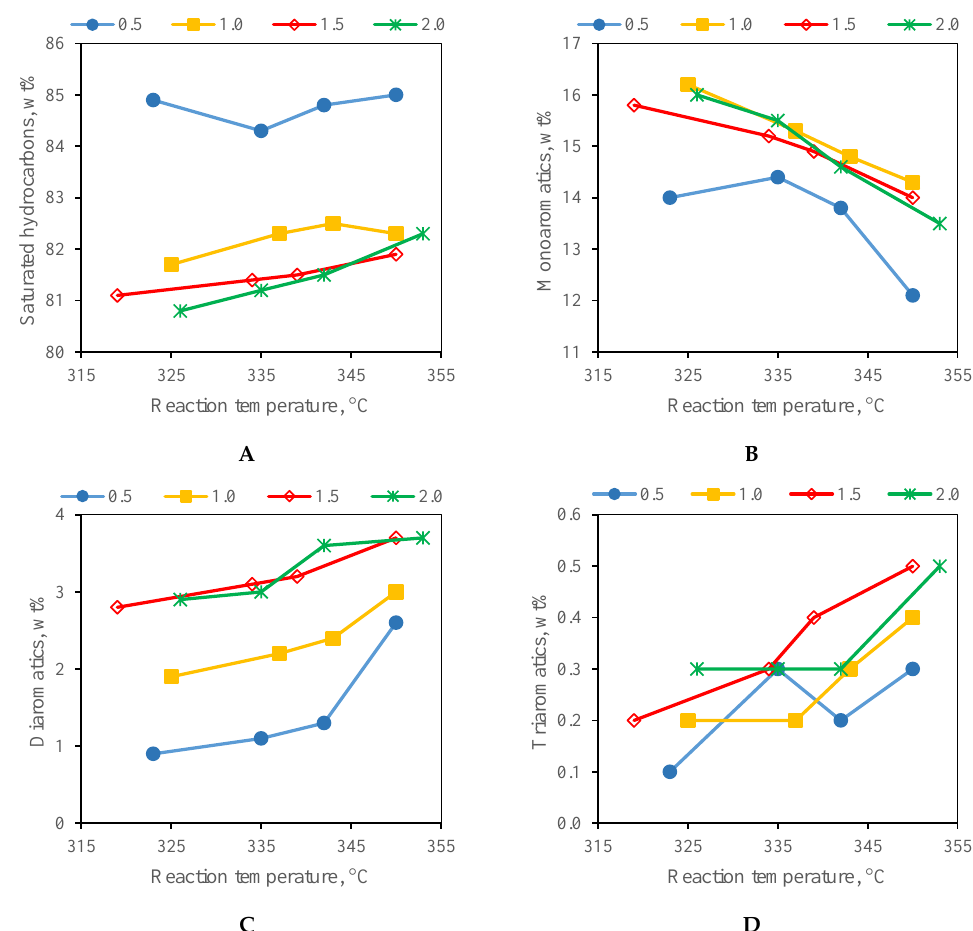
Figure 3. Group-type composition of all the liquid products obtained by the hydrotreating of F20 feedstock at the WHSV of 0.5–2.0 h −1 ( A ) saturated hydrocarbons; ( B ) monoaromatics; ( C ) diaromatics; ( D ) triaromatics. Table 6. The content of n-alkanes in P20 liquid products.